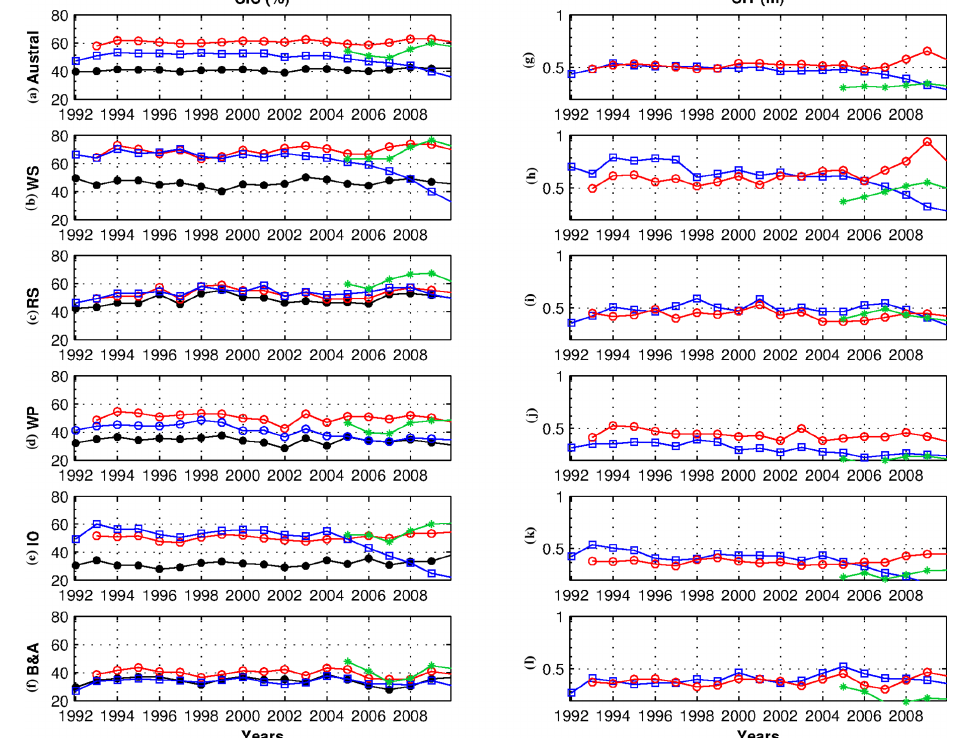
Figure 2. Annual mean sea ice concentration (left) and thickness (right) of each sector of the Southern Ocean. The red ( (cid:13) ), green (*) and blue ( (cid:3) ) lines are the annual mean time series from UR025.4, SoSE and ECCO2, respectively, and the circles, stars and squares are the respective annual values. The black ( • ) line with the filled black circles represents the mean sea ice concentration from the Goddard Satellite observations. The sectors are labeled WS (Weddell Sea), RS (Ross Sea), WP (Western Pacific), IO (Indian Ocean) and B&A (Bellingshausen and Amundsen